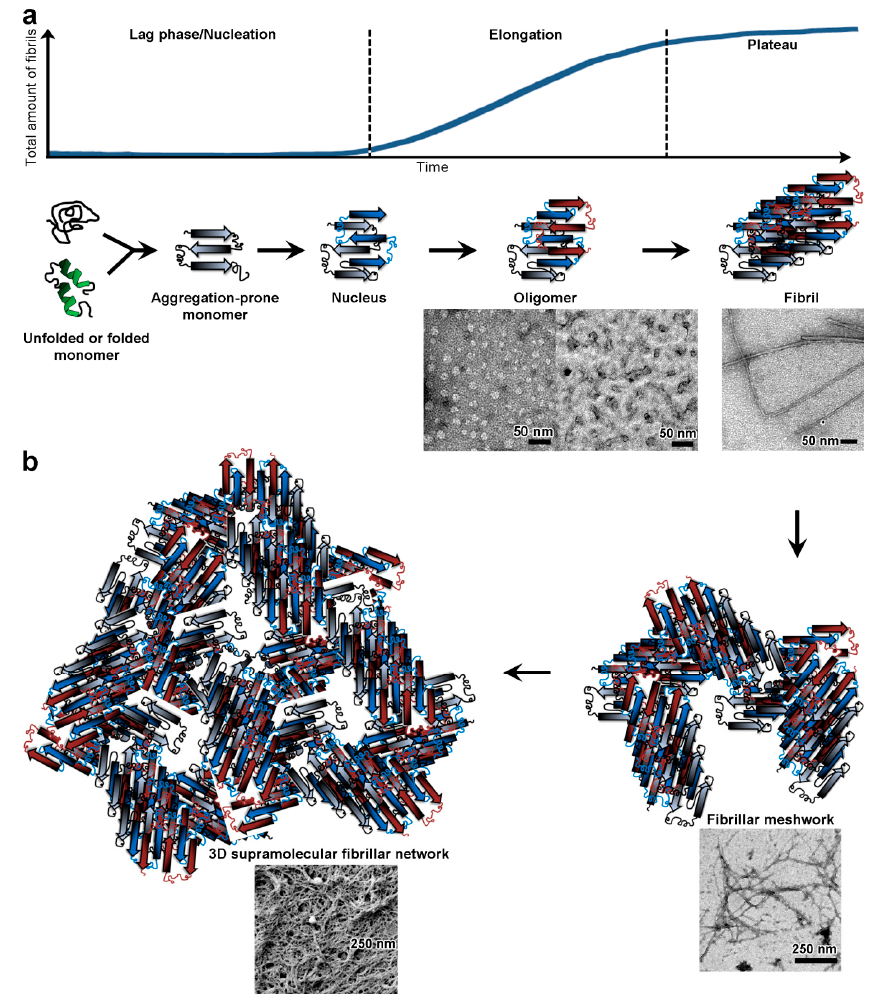
Figure 1. From monomer to hydrogel. ( a ) Formation of amyloid fibrils. Amyloidogenesis is a nucleation-dependent polymerisation process, which shows a typical sigmoidal behaviour. When followed over time, fibril formation can classically be divided into three phases: nucleation typically characterised by a lag phase, elongation and a plateau. During nucleation, monomers (either unfolded or folded) have to undergo a conformational change to adopt an aggregation prone β -sheet conformation. Then aggregation-prone monomers have to come together in the right conformation and orientation, in an energetically unfavourable step, to form the minimal stable assembly, the nucleus. Once formed, the nucleus serves as a structural template for cooperative elongation. The assembly process becomes energetically favourable and proceeds through addition of aggregation-prone monomers onto the nucleus during elongation to form assembly intermediates or oligomers. Morphologically, by transmission electron microscopy, these oligomers appear as spherical structures (doughnut-like of 10–20 nm diameter) or small rods/protofibrils of various length (~20 to 70 nm). Oligomers carry on growing at the expense of monomers until the monomer concentration falls to the critical fibrillar concentration (the minimum monomer concentration required to form fibrils) and then fibril extension ceases (plateau phase). Typically, by transmission electron microscopy, fibrils can be several µ m long with a width of 10 to 20 nm; ( b ) Formation of a 3D supramolecular fibrillar network. Beyond fibril formation, amyloid fibrils can interact with one another through a range of non-covalent and non-specific interactions to first form a fibrillar meshwork. By transmission electron microscopy, several µ m long fibrils are seen to mostly laterally pack together, as well as twisting around one another. This fibrillar meshwork then proceeds, through further fibrillar interactions and entanglements, to